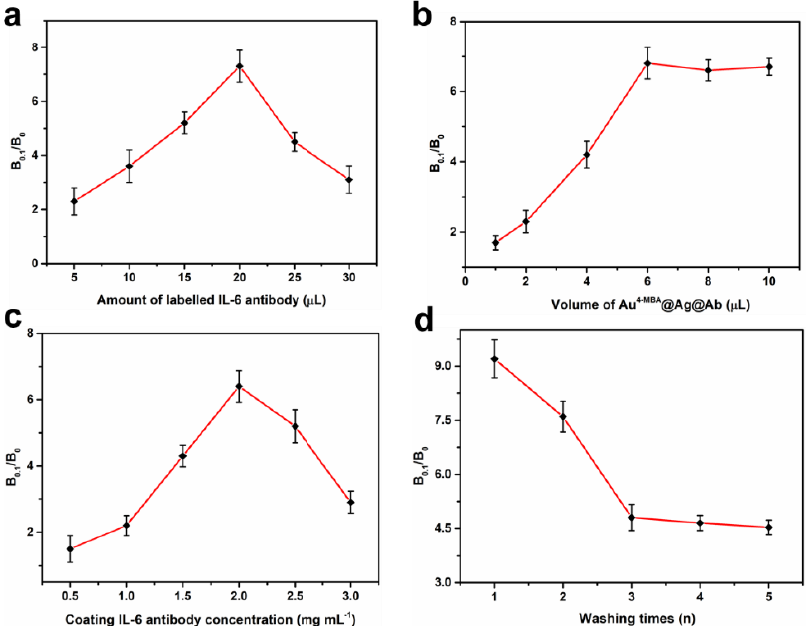
Figure 4. Optimization of the SERS IFA conditions: ( a ) optimization of the amount of labelled anti- body in the preparation of Au 4-MBA @Ag@Ab; ( b ) optimization of the amount of Au 4-MBA @Ag@Ab solution; ( c ) optimization of coating IL-6 antibody concentration on the NC membrane; ( d ) optimiza- tion of different washing times.